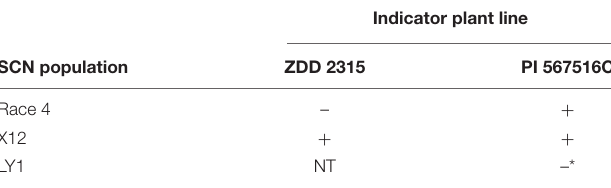
TABLE 1 | Differential reaction of the new, highly virulent X12 and LY1 populations but also race 4 on the newly proposed differential lines, ZDD 2315 and PI 567516C.